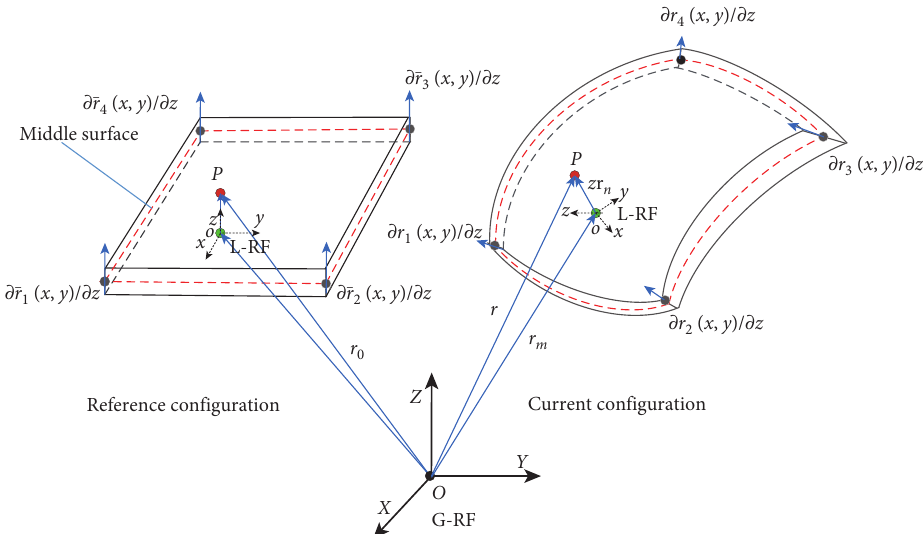
Figure 4: Kinematic description of the deformable ANCF shell element.